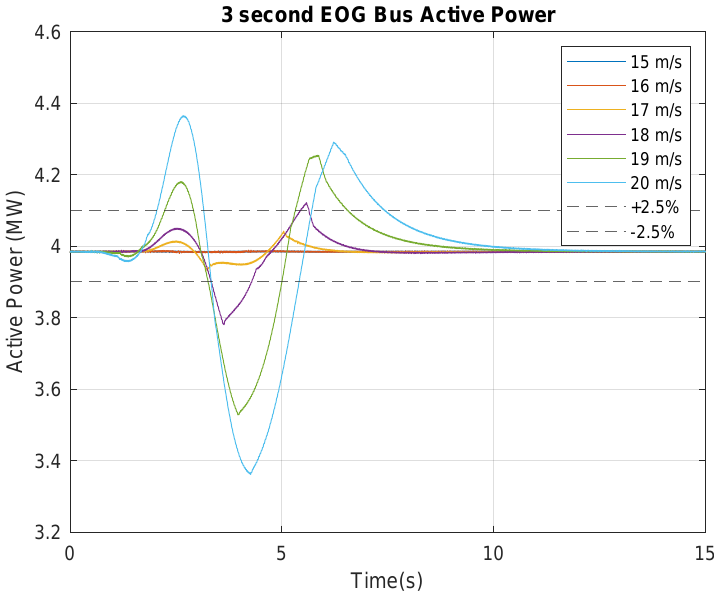
Figure 14. Bus active power response to 3 s EOG